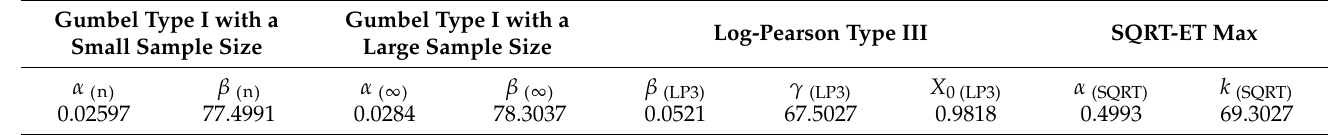
Table 4. Characteristic parameters of the probability distribution functions.